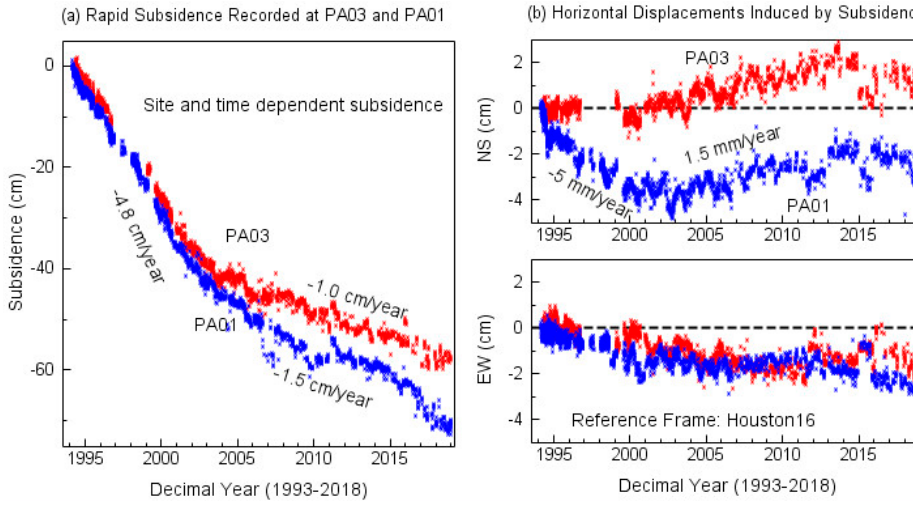
Figure 12. Comparisons of three-component displacement time series recorded by two PAM GPS stations (PA01 and PA03, 9.3-km apart) in the Jersey Village area (see Figure 1). The displacements are derived from the daily PPP solutions with respect to Houston16.